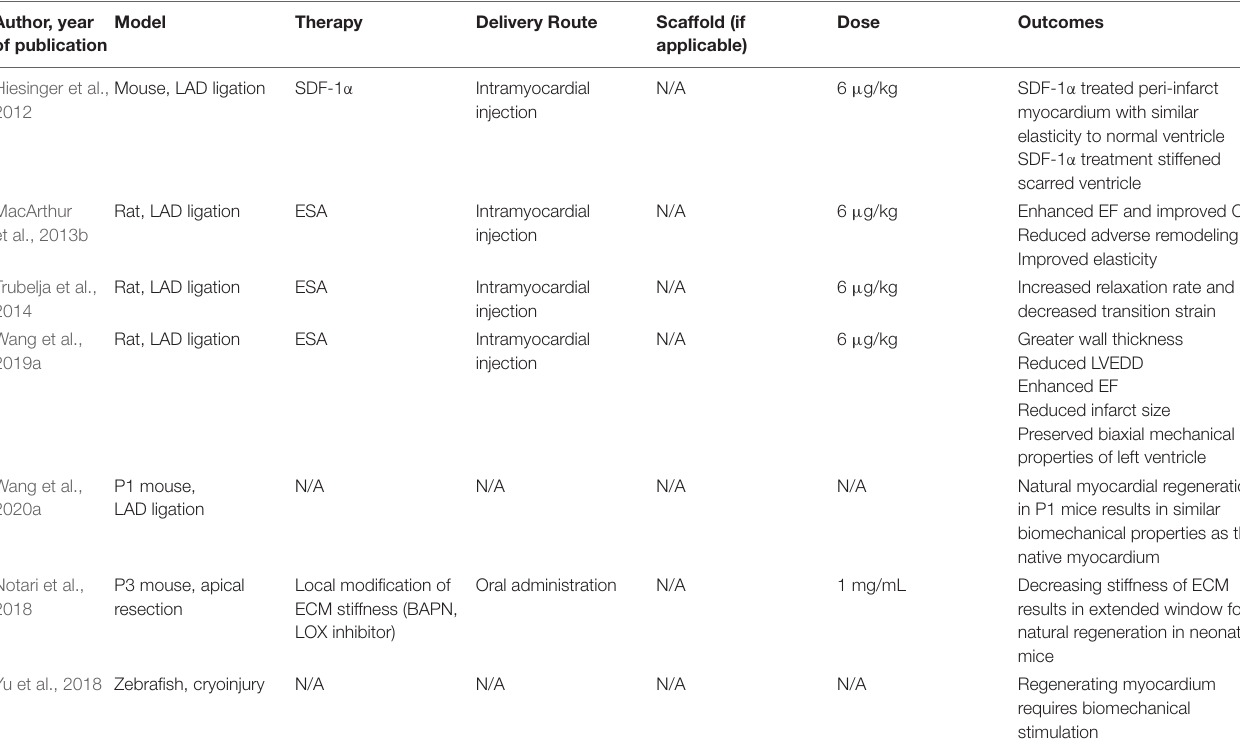
TABLE 4 | In vivo biomechanical engineering approaches to myocardial